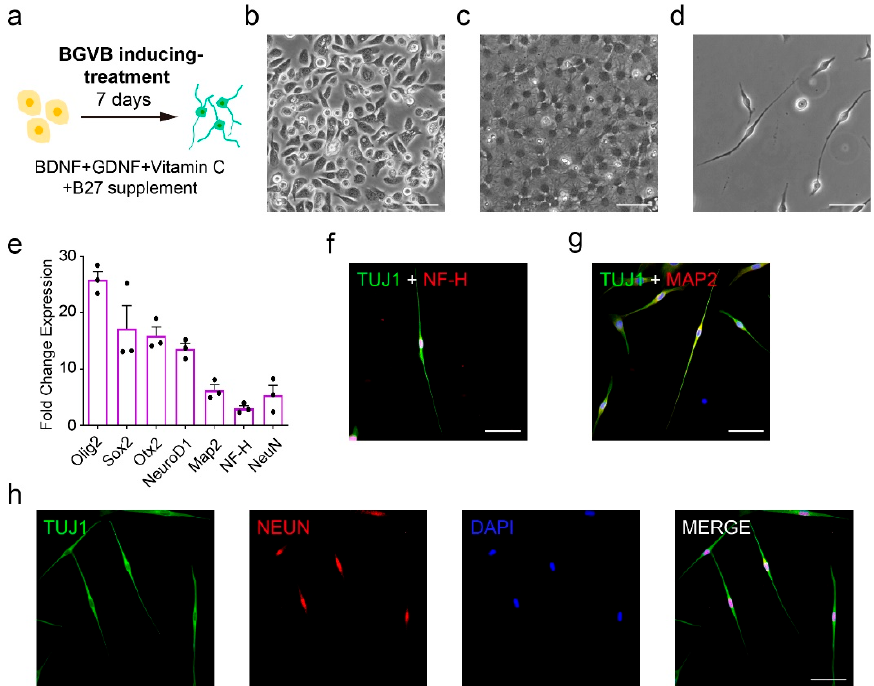
Figure 2. The neural characteristic examination of hAEC-neural-like cells induced by the BGVB approach. ( a ) Experimental schematic of the BGVB inducing-treatment approach; ( b ) the morphology of non-treated hAECs; ( c ) the morphology of hAECs after BGVB treatment for 4 days; ( d ) the morphology of BGVB-treated hAECs 3 days after passaging; ( e ) the activation of neural markers after a 7-day period of BGVB inducement, normalizing the non-treated hAECs as 1, n = 3; ( f , g ) the immunofluorescence staining of neural markers TUJ1, NF-H and MAP2 after BGVB inducement; ( h ) the immunofluorescence staining of mature neuron nucleus protein NeuN after BGVB treatment; ( i ) the flow cytometry results of HLA antigens of hAECs before and after treatment with the BGVB approach. Scale bars: ( b – d ): 50 µ m; ( f , g ): 50 µ m; ( h ): 50 µ m.